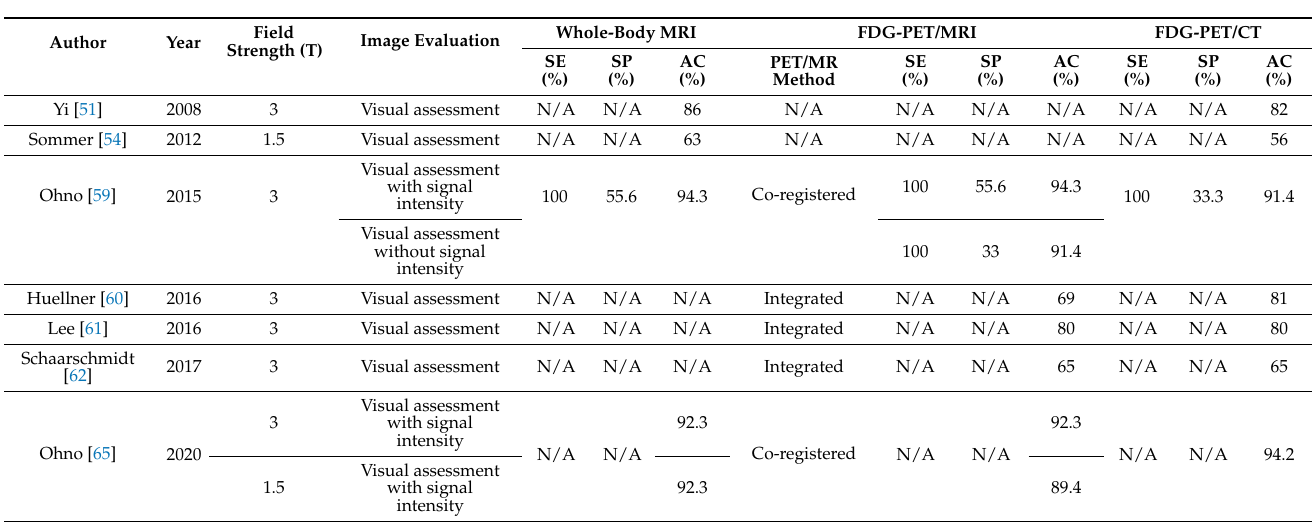
Table 5. Summary of diagnostic performance of T-factor assessment using whole-body MRI or